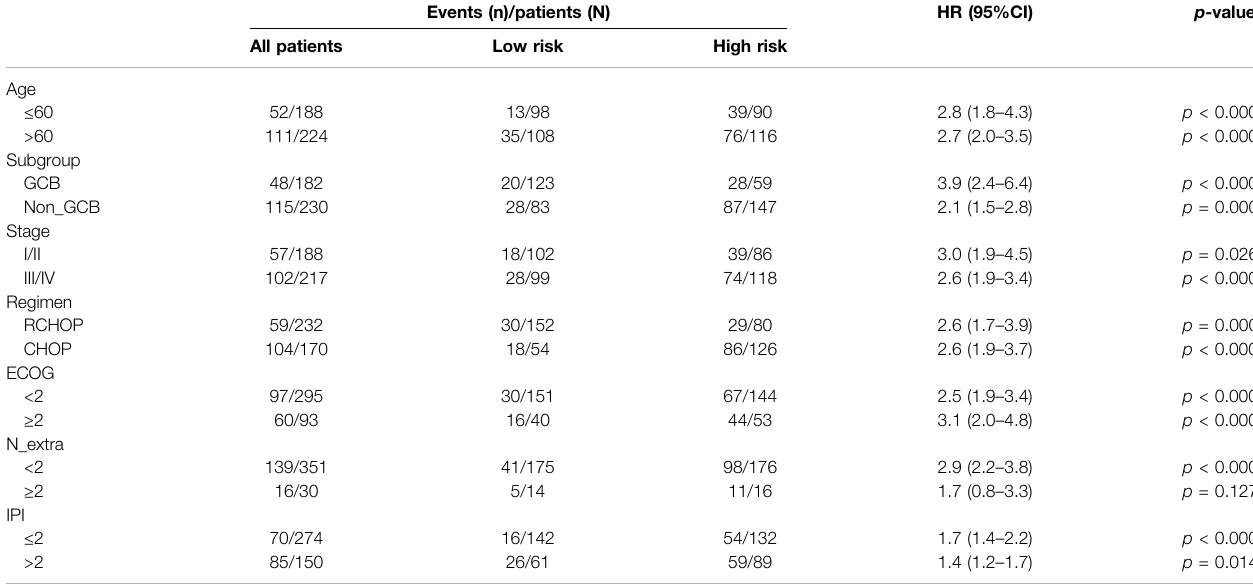
TABLE 4 | Strati fi ed analysis for DLBCL patients based on the gene